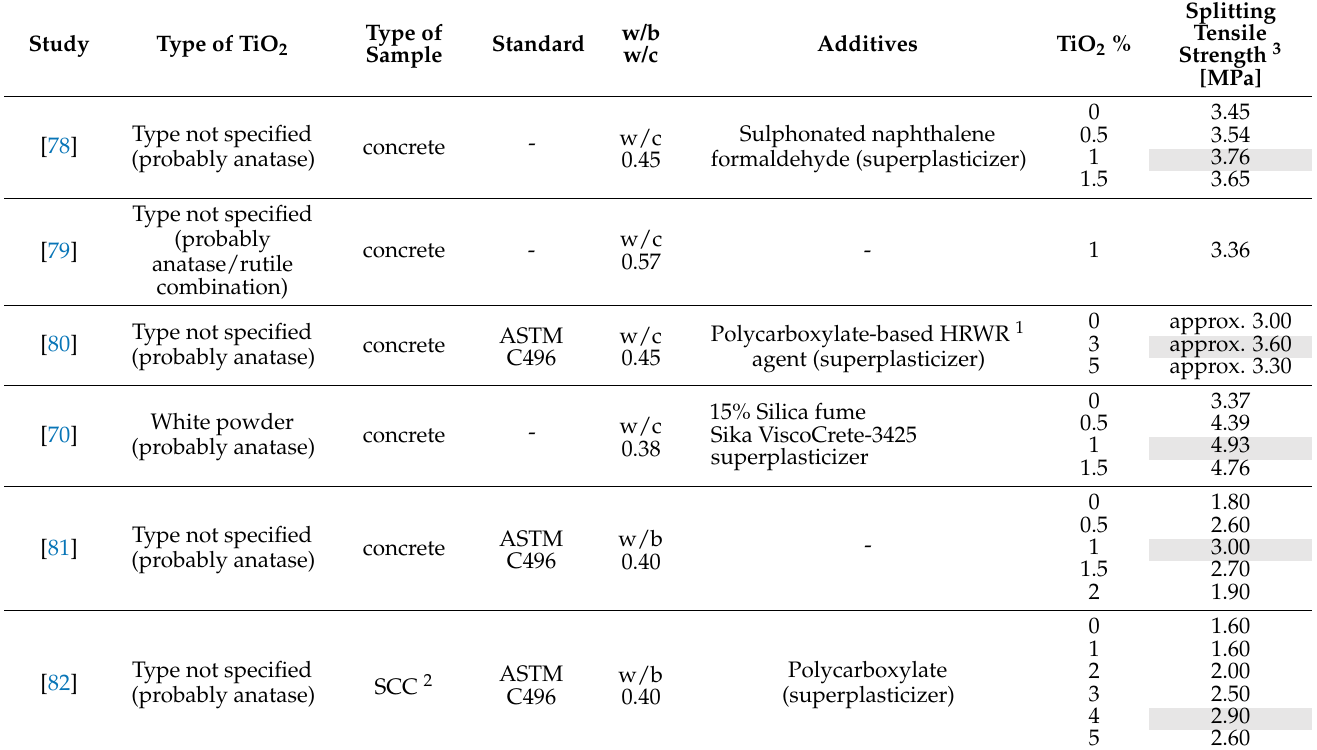
Table 6. Splitting tensile strength values mortar/concrete specimens modified with TiO 2 nanoparti- cles, at room